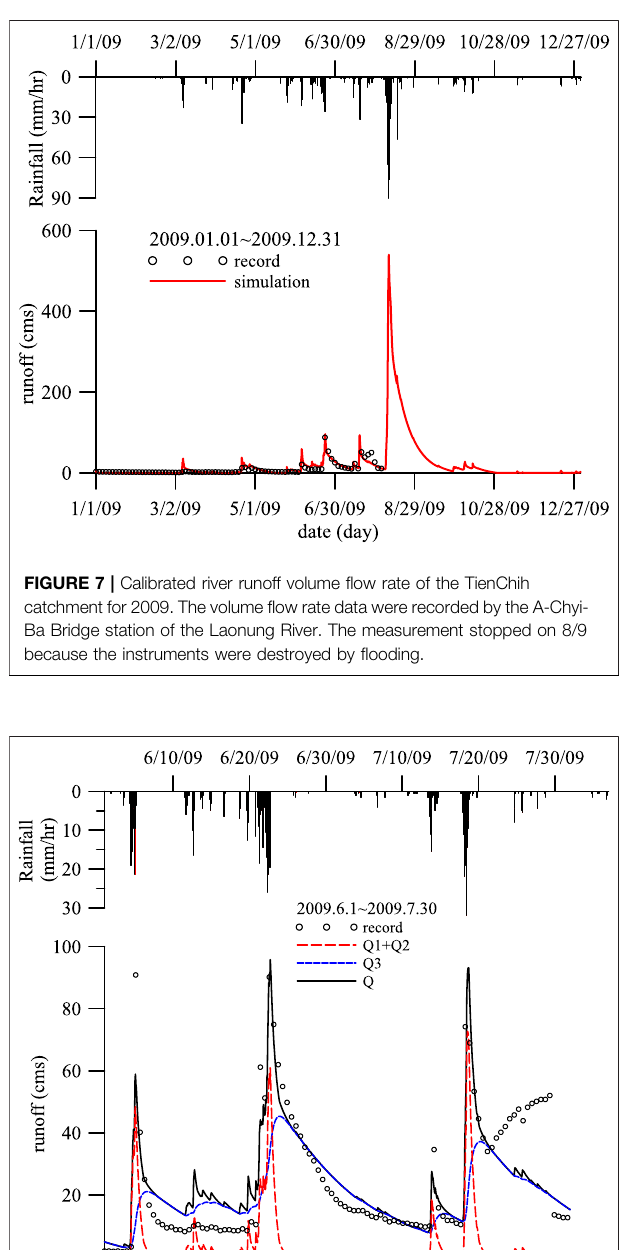
plotted in Figure 8 . The discharge from the top tank is responsible for the peak river fl ow rate immediately after each rainfall event while the discharge from the bottom tank contributes to the lagged recessing river discharge. This